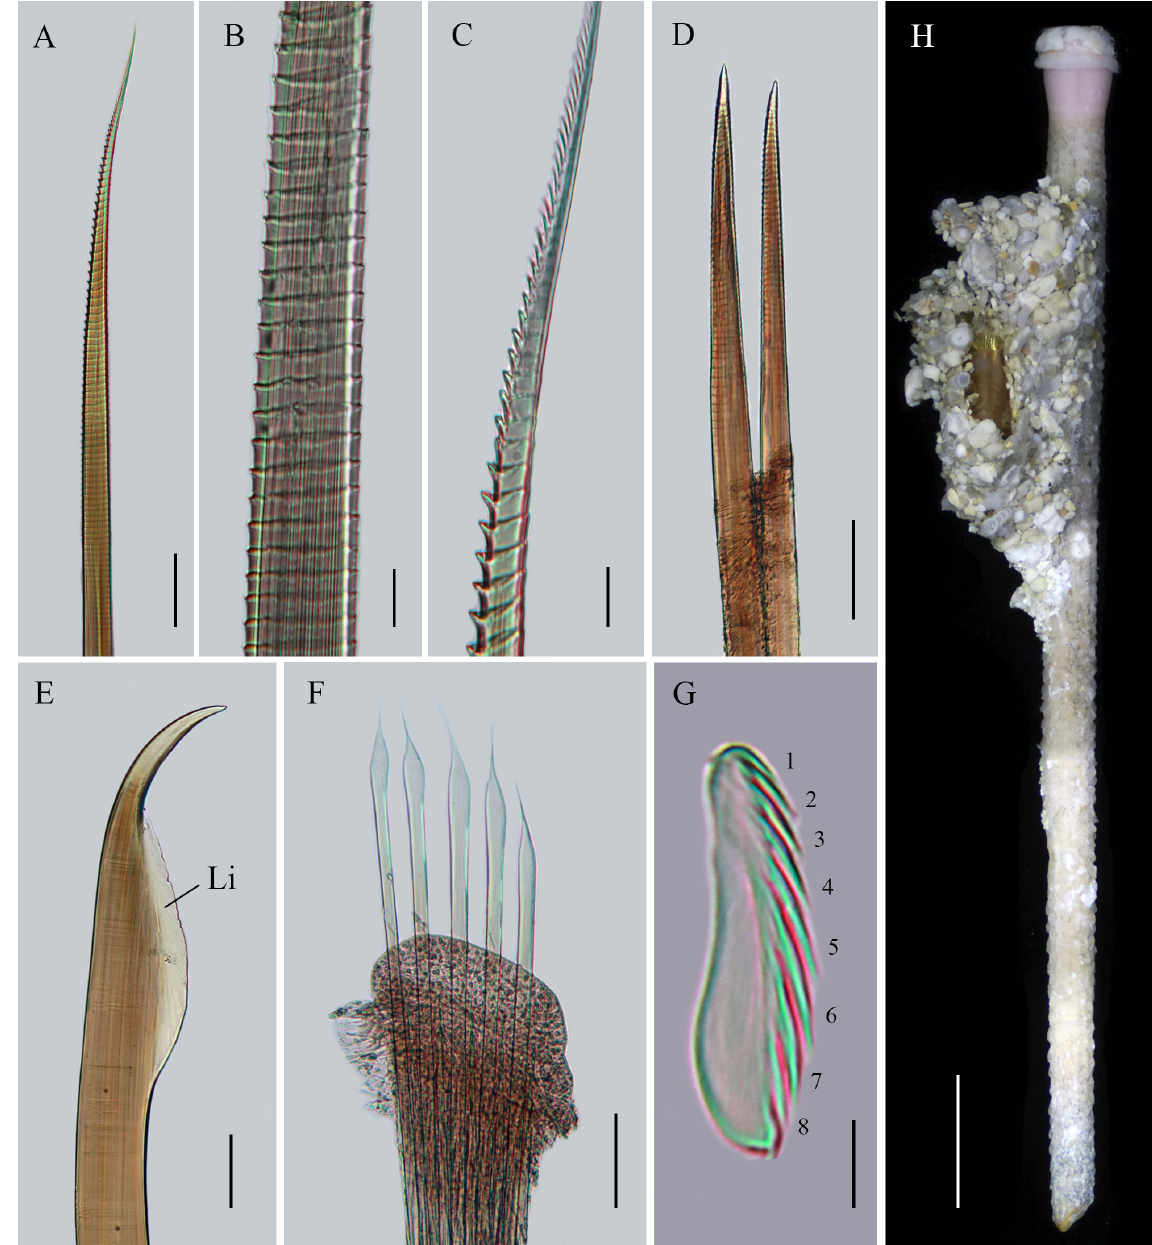
Fig. 10. Phalacrostemma dorothyae Kirtley, 1994 (UMML-22.1183). A . Outer palea. B . Proximal region of outer palea. C . Middle region of outer palea. D . Inner paleae. E . Nuchal hook. F . Parathoracic notochaetae. G . Uncini. H . Specimen (UMML-22.1186) in its tube attached to a spine of sea urchin. Abbreviation: Li = limbation. Numbers indicate the rows of teeth. Scale bars: A, D–F = 100 µm; B–C = 20 µm; G = 10 µm; H = 0.5